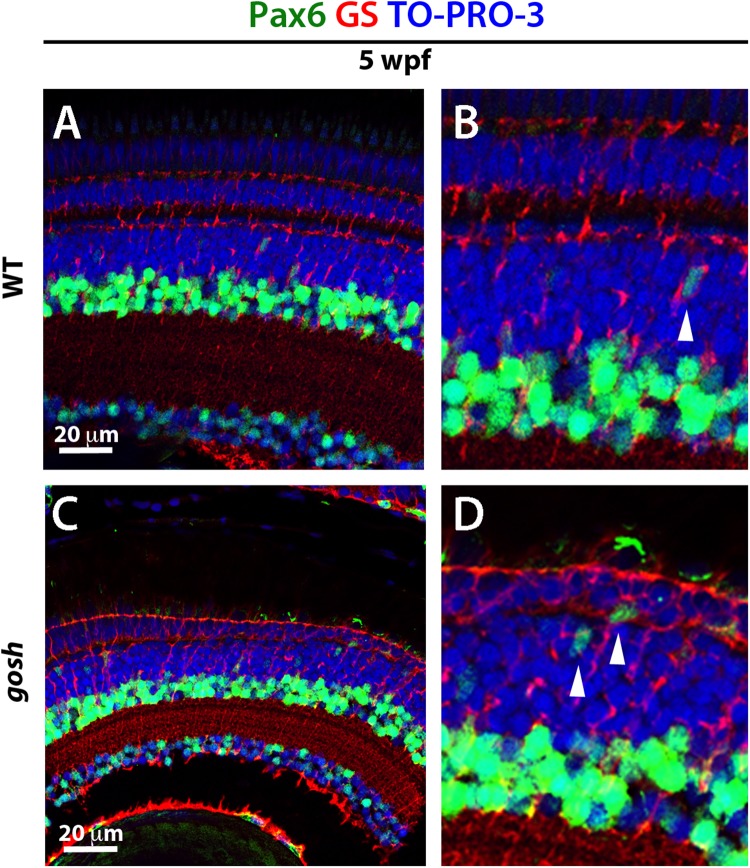
NPCs express Pax6 during the regenerative response in gosh mutants. Wild-type and gosh mutant retinas labeled with antibodies against Pax6 and GS, which are expressed in NPCs and Müller glia, respectively. In wild-type retinas, Pax6 is observed in amacrine cells and retinal ganglion cells (A,B). Weaker signals were observed in NPCs migrating to the ONL (B, arrowhead). Five-wpf gosh mutant retinas show that Pax6 is expressed in amacrine cells and retinal ganglion cells, as well as probable NPCs migrating toward the ONL (C,D, arrowheads).